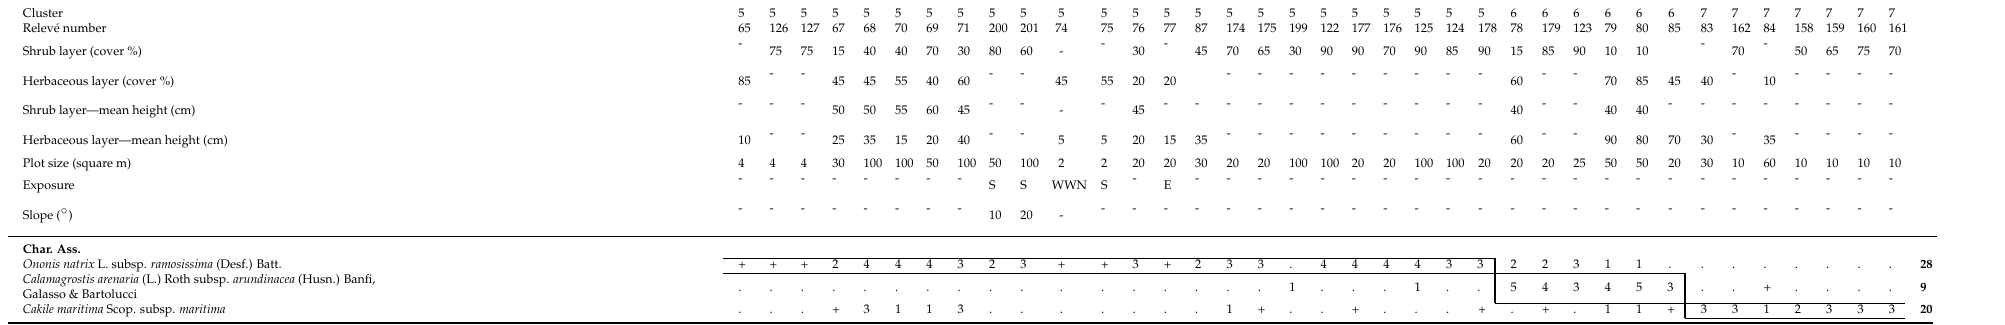
Plotsize(squarem) Slope( ◦ ) Char. Ass. Ononisnatrix L.subsp. ramosissima (Desf.)